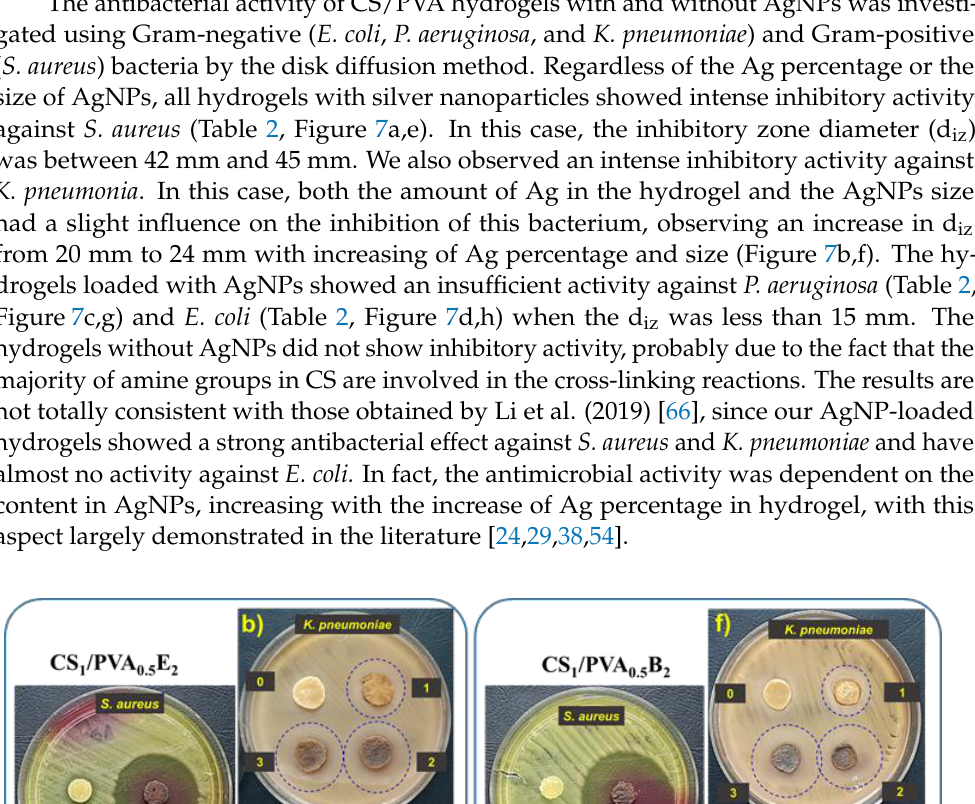
Table 2. Antibacterial properties of the CS 1 /PVA 0.5 E 2 and CS 1 /PVA 0.5 B 2 hydrogels against E. coli , P. aeruginosa , S. aureus , and K. pneumoniae.